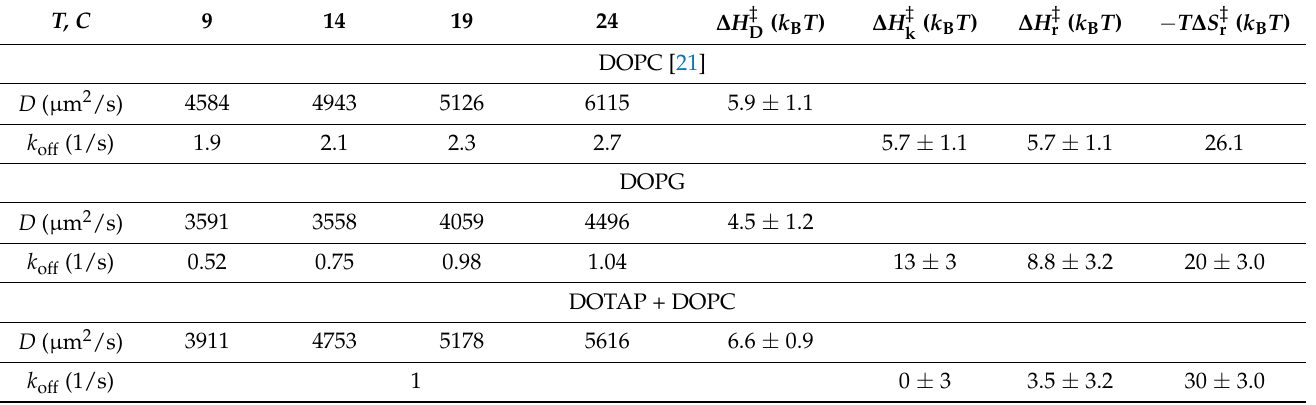
Table 2. Summary diffusion coefficients and decay rates for proton kinetics near the DOPG and DOTAP/DOPC membranes (this work) and the DOPC membrane